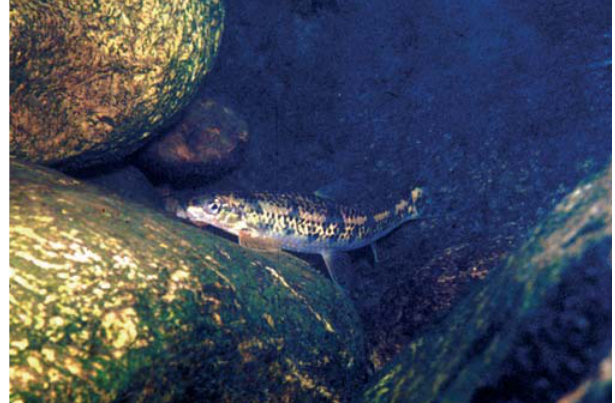
Fig. 6. Apareiodon ibitiensis specimen using its expanded and horizontally orientated paired fins to hold its position over a rocky surface while grazing on periphyton in the riffles substrate, during daytime (photo: Ricardo M.C. Castro).